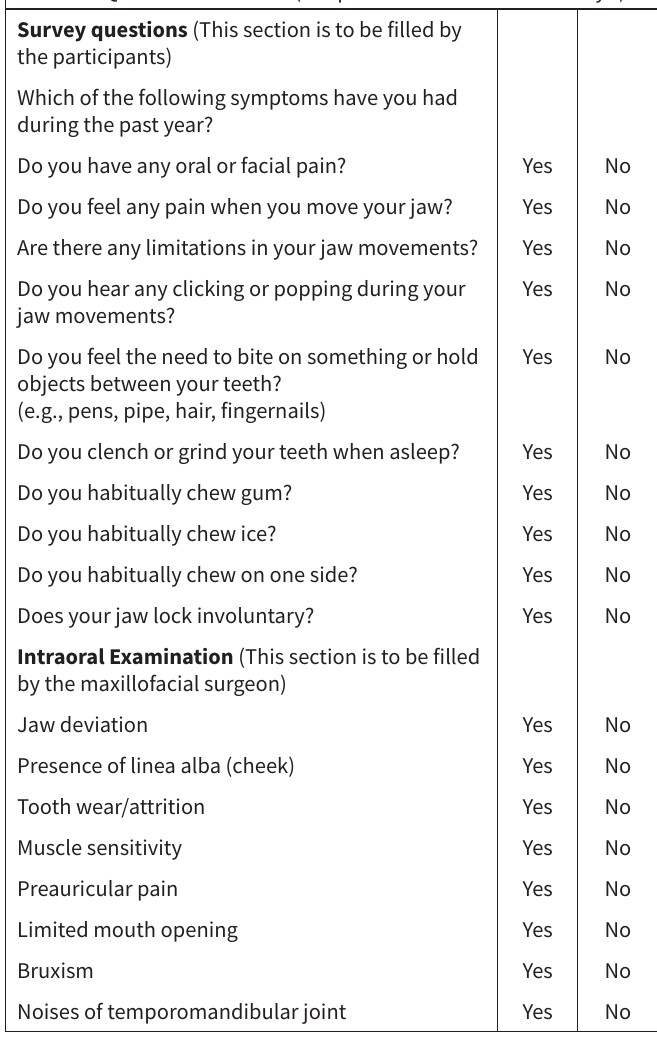
Table 1. Questionnaire Form (Adapted From Schiffman’s Study 15